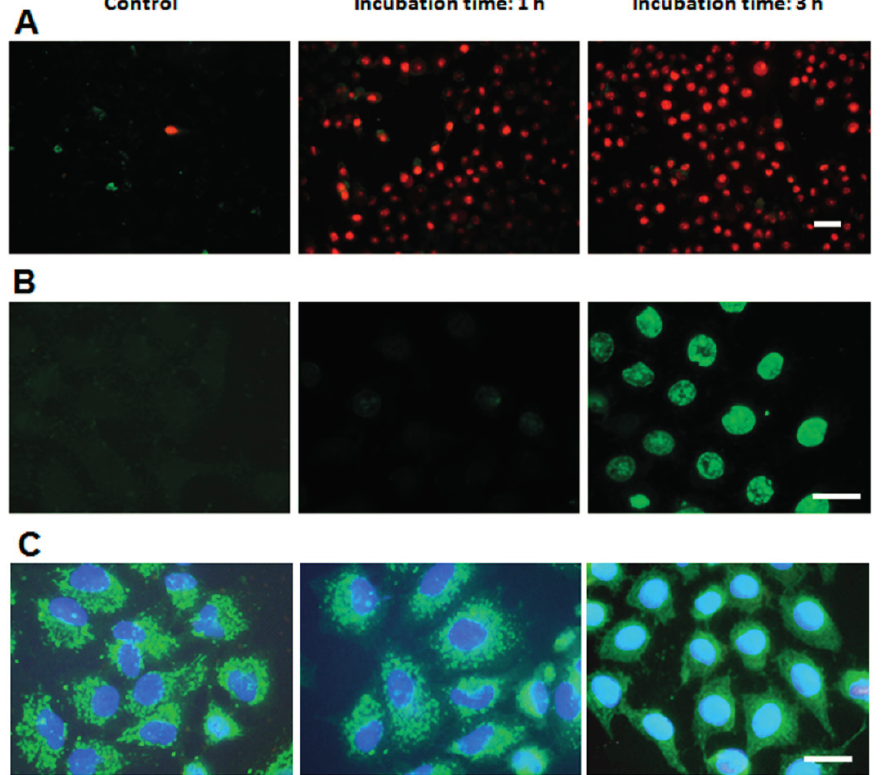
(Figure 3B) is a typical characteristic of apoptotic processes. Cells incubated 1 h with ZnPc, irradiated and processed 3 h later do not exhibit positive staining, showing images similar to control cells. On the contrary, cells incubated 3 h with ZnPc and processed 3 h after irradiation showed a strong nuclear labeling. The translocation of cytochrome c (cyt-c) from mitochondria to the cytoplasm was also studied (Figure 3C). In control cells, cyt-c is located inside mitochondria, and cells treated 1 h with ZnPc and processed immediately after irradiation still retain cyt-c inside mitochondria. This situation continued 2 h after irradiation. By contrast, cells incubated with PS during 3 h and then irradiated exhibited cyt-c translocation immediately after irradiation, appearing as a green diffuse cytoplasm fluorescence that does not allow one to distinguish the mitochondrial